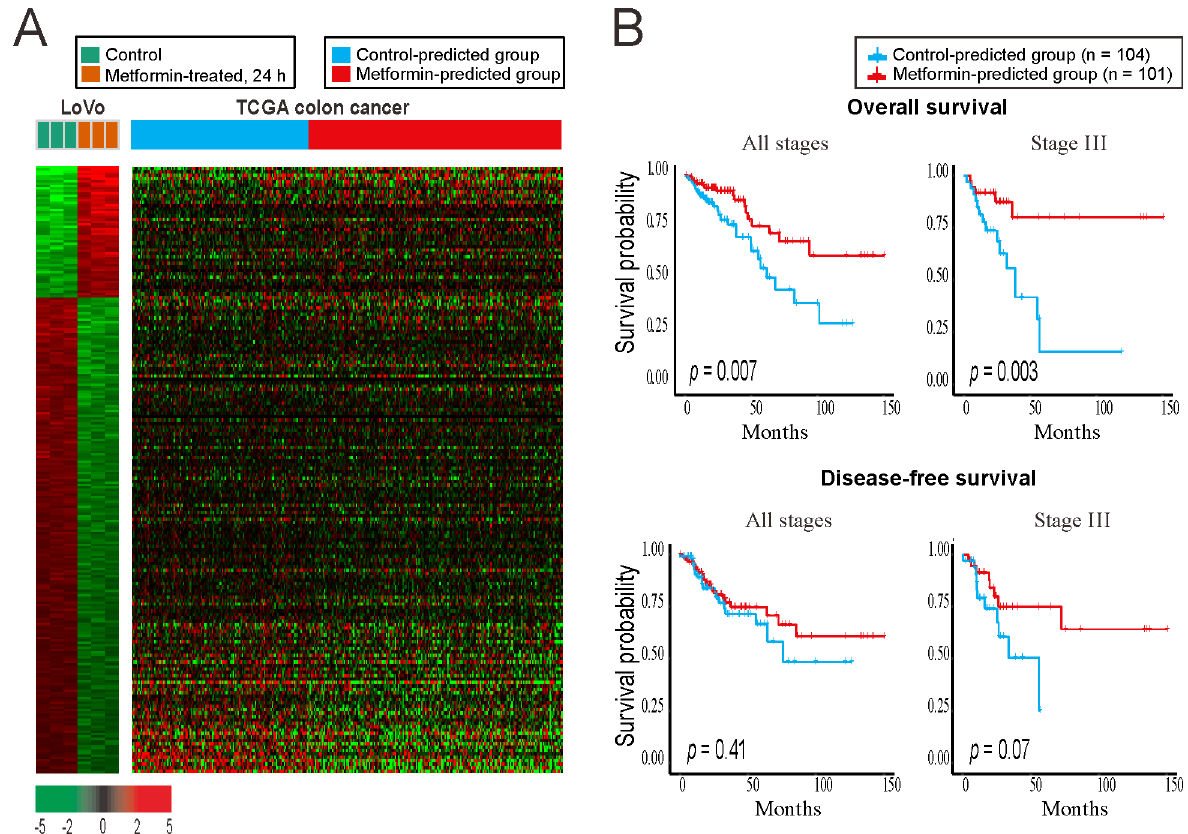
Fig 1. Gene expression profiles of colon cancer samples stratified by the metformin-treated gene signature of colon cancer cells (GSE67342). ( A) Heatmap of the gene signature from the metformin-treated LoVo colon cancer cells and the control LoVo colon cancer cells (left). The prediction and grouping of TCGA colon cancer patients by the signature from the LoVo cells (right). (B) Kaplan–Meier survival plots of TCGA colon cancer patients by the results of prediction. The metformin-predicted group showed the better survival rate.